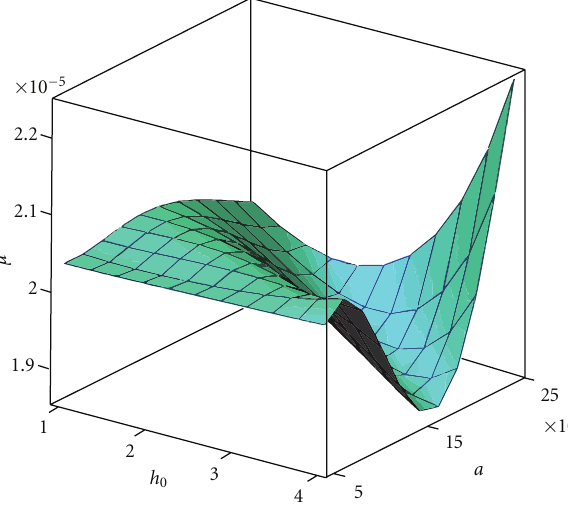
Figure 26: E x ( h 0 , β s ) for m = 2 × 10 − 5 and a = 150000 ,